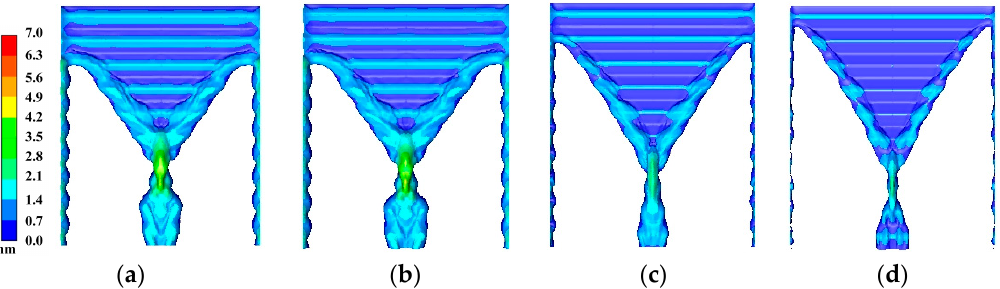
Figure 11. Film distribution for different fluids ( We = 0.76, ϕ = 60°): ( a ) water; ( b ) seawater; ( c ) R290; and ( d ) O 2 . and ( d ) O 2